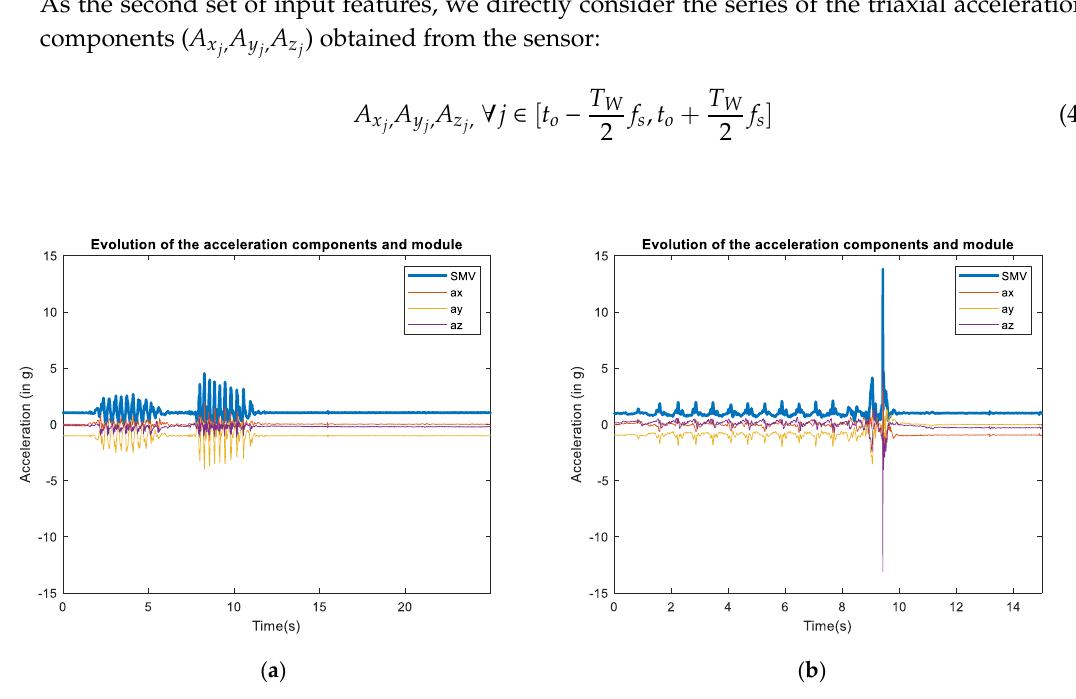
Figure 1. Snapshot of the progress of the acceleration components ( Ax, Ay, Az ) and magnitude (SMV) for two samples in the SisFall dataset: ( a ) An ADL (walking upstairs and downstairs quickly) and ( b ) a fall (forward fall while walking caused by a trip).